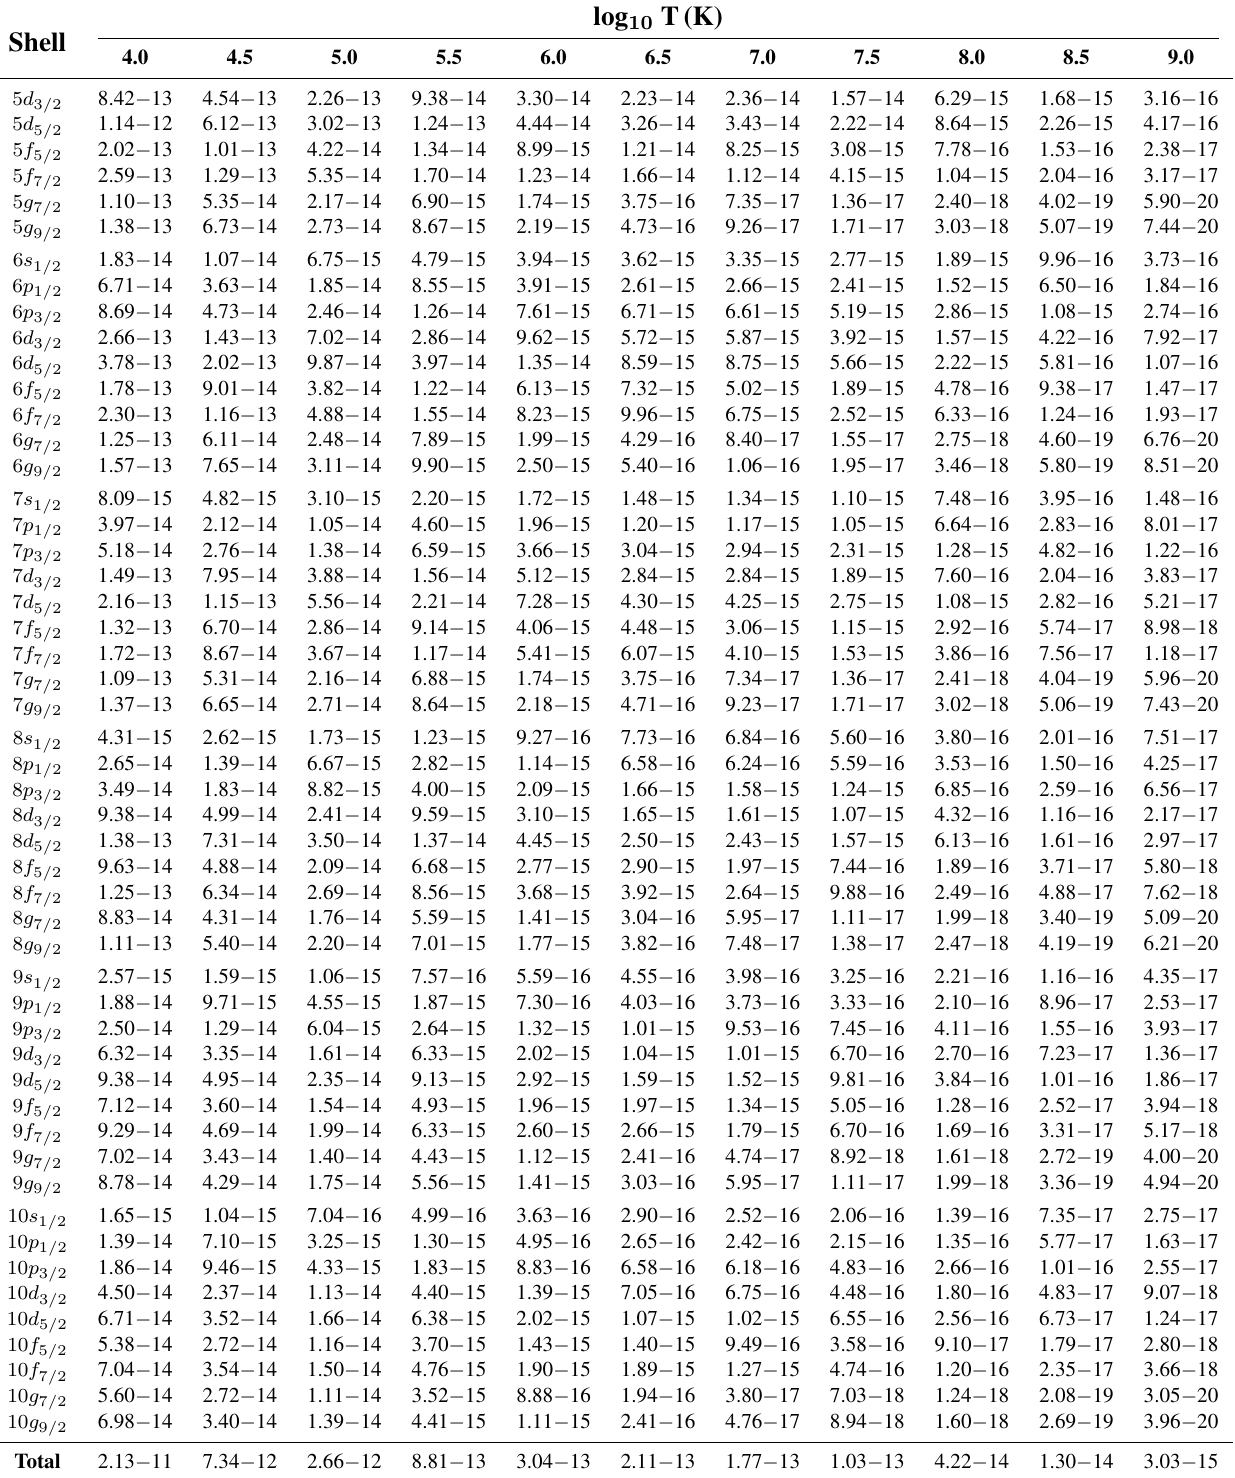
Table A1. Radiative recombination rate coefficients for W 6+ in cm 3 × s − 1 . Presented for a value to its right is the decimal order, e.g., 8.42–13 = 8.42 × 10 − 13